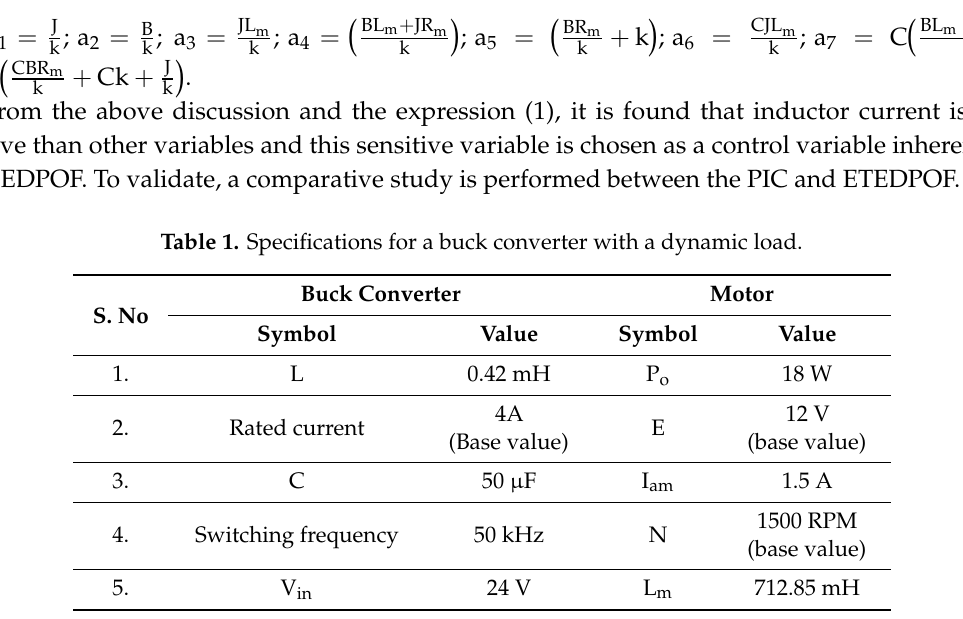
Table 2. Sensitivity analysis for ETEDPOF control of a buck converter-fed DC motor.